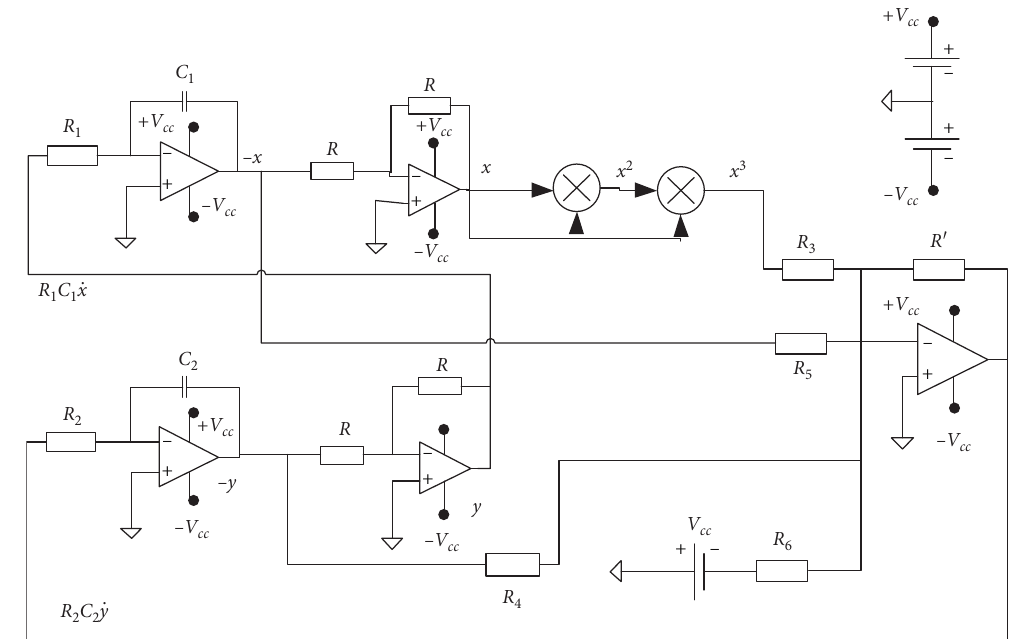
Figure 2: Electrical analogue computer of microtubule’s